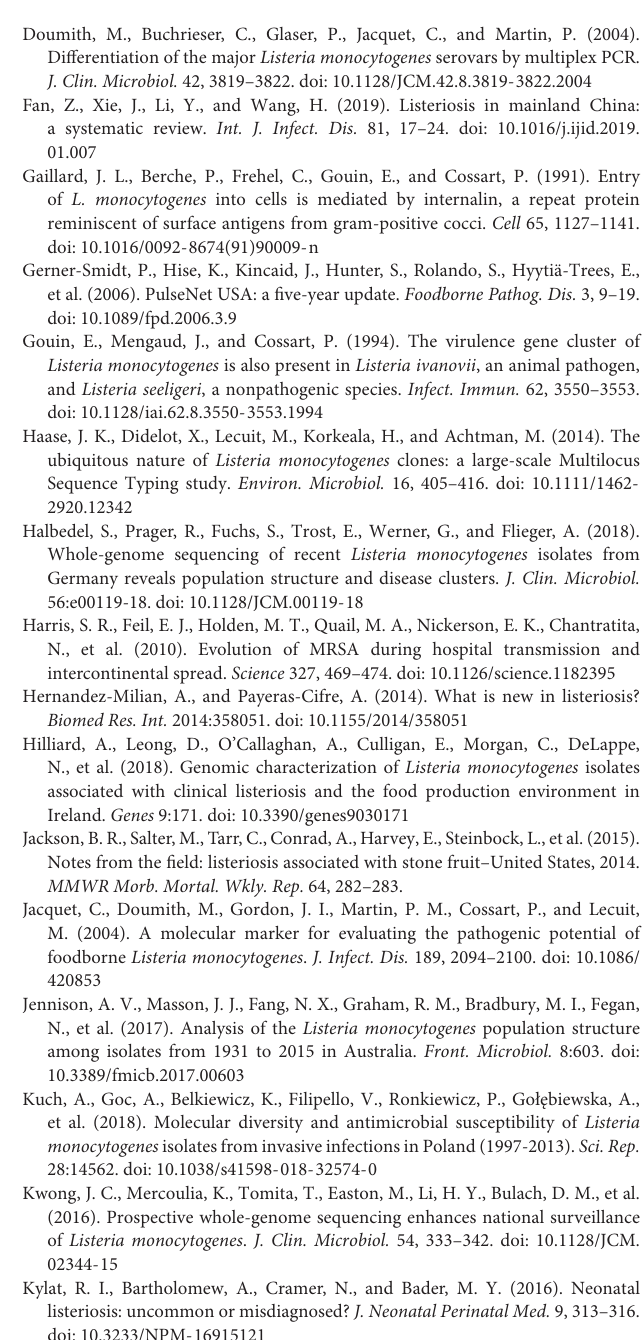
Supplementary Figure 1 | Minimum spanning tree (MST) of 86 L. monocytogenes isolates that formed 30 complexes with ≤ 7 different alleles